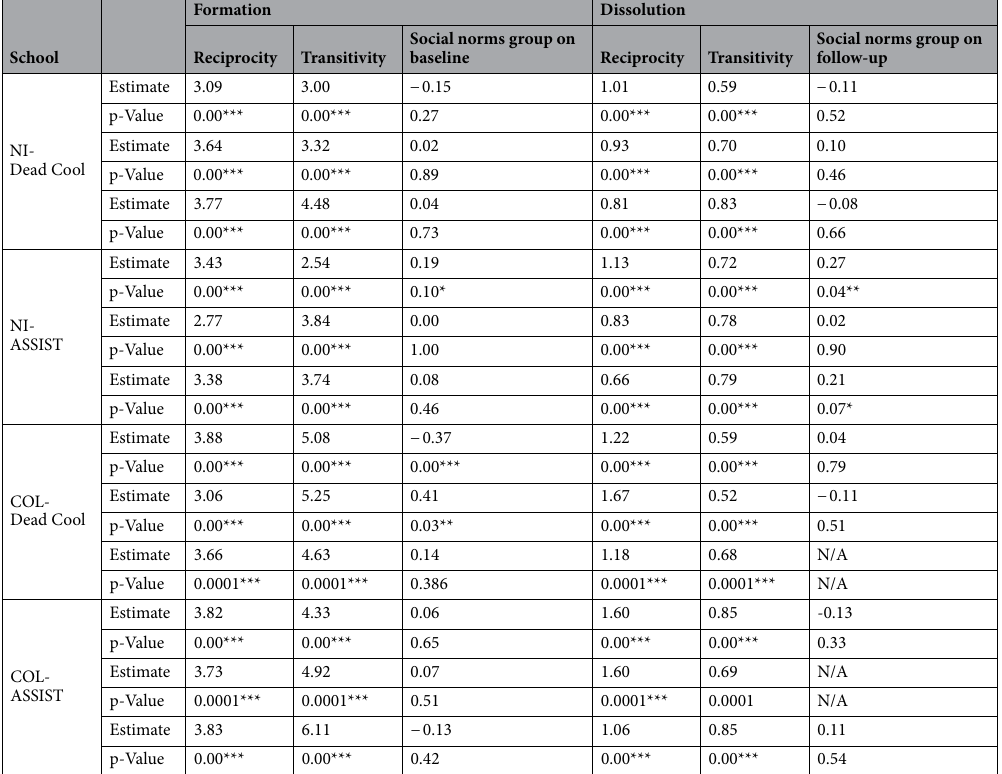
Table 4. Coefficients and p-values resulting from the STERGM model for each network. Transitivity represents the probability that friends of friends are also friends; Reciprocity represents the percentage of friendship nomination that is returned; N/A did not converge; p < 0.1; *p < 0.05; ***p <